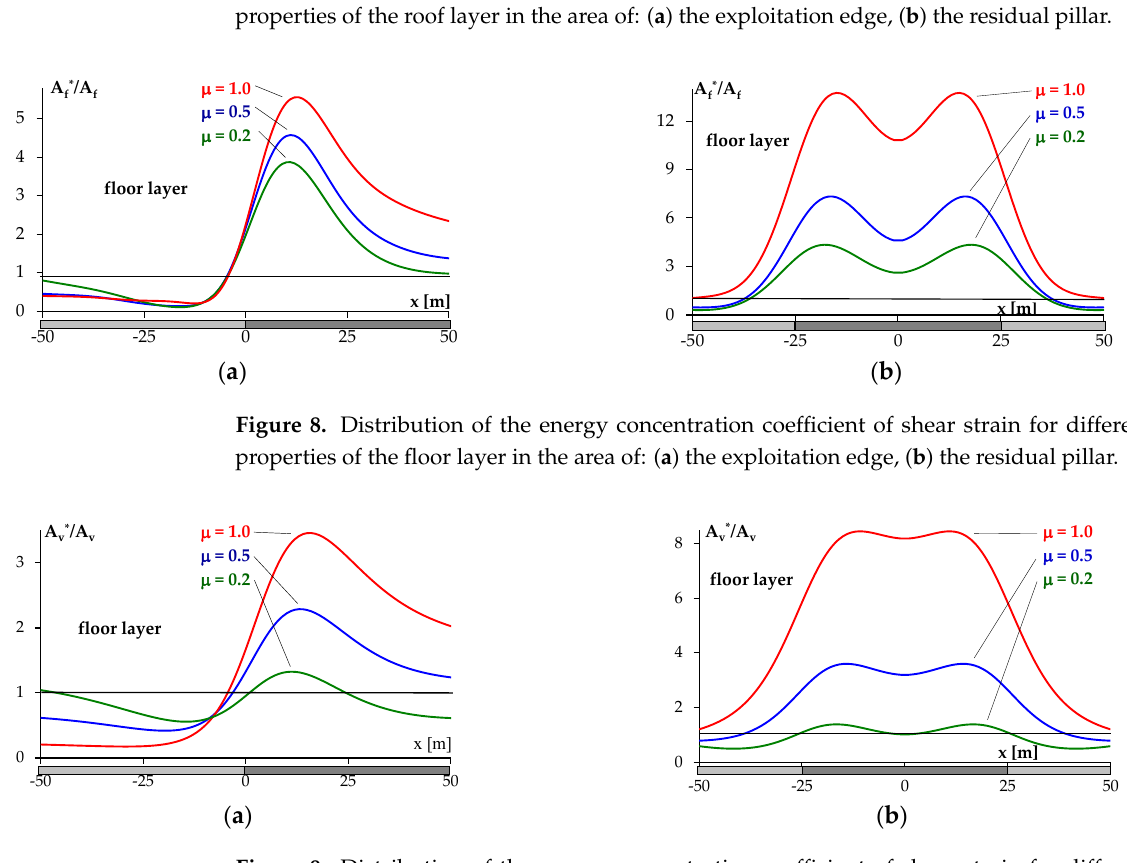
Figure 9. Distribution of the energy concentration coefficient of shear strain for different strain properties of the floor layer in the area of: ( a ) the exploitation edge, ( b ) the residual pillar.